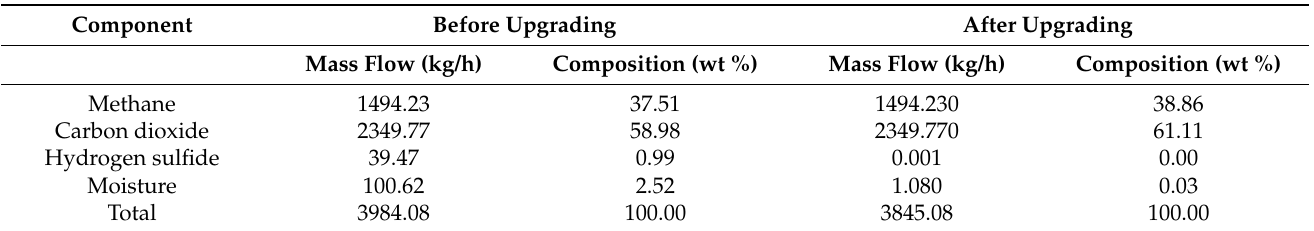
Table 9. Simulated biogas composition before and after upgrading.